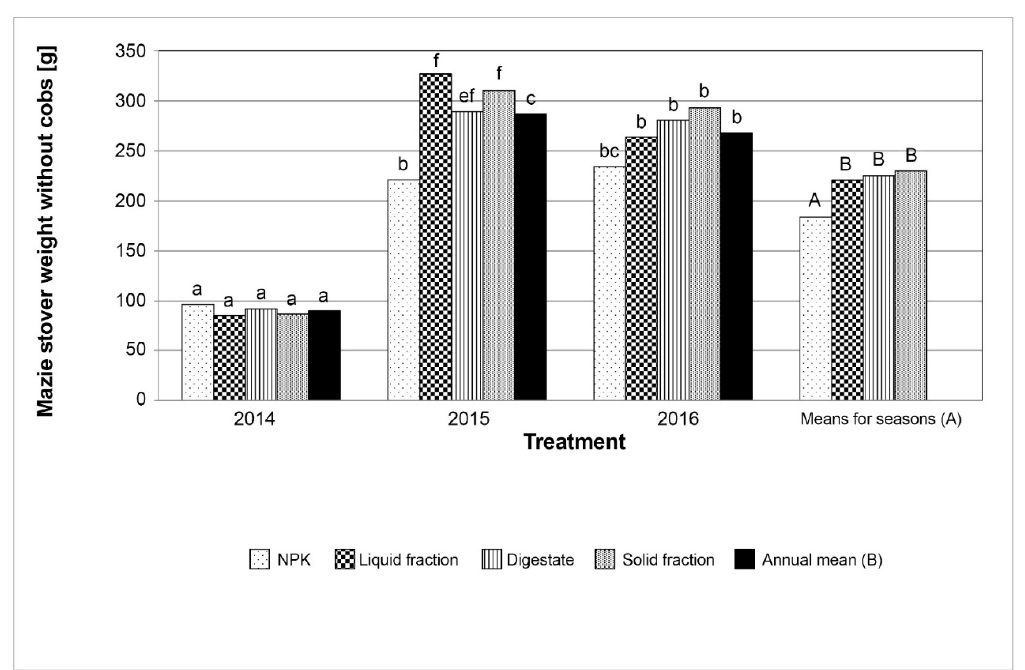
Figure 5. Weight of maize stover in respective growing seasons and experimental treatments. Legend as at Figure 4. The average weight of above ‐ ground biomass from a single maize plant grown on a control plot was significantly the lowest (Figure 6), whereas the digestate application did not affect this value. Differences in above ‐ ground biomass of maize between the growing seasons were found to be statistically significant, and a higher weight of above ‐ ground biomass was noted in the season of 2015 compared to that in the other two seasons of the study.